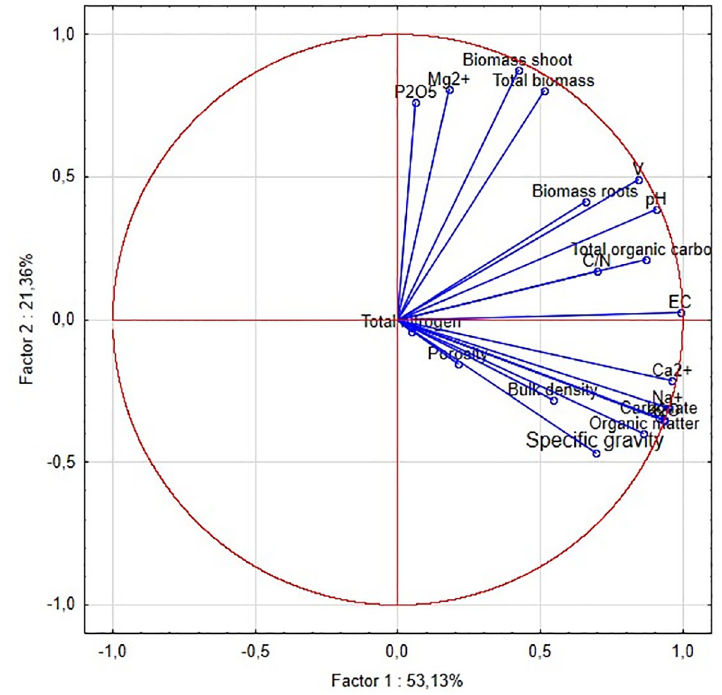
Fig 3. Projection of the cases on the factor plane. The correlation matrix is singular, so the generalized reciprocal method is used.